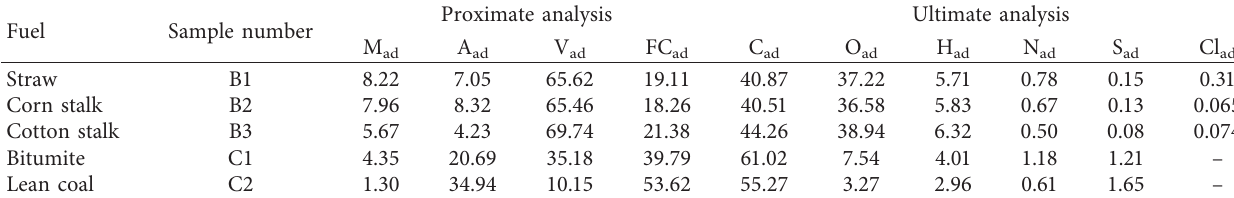
Table 1: Proximate and ultimate analysis of fuels (air-dried) (%).